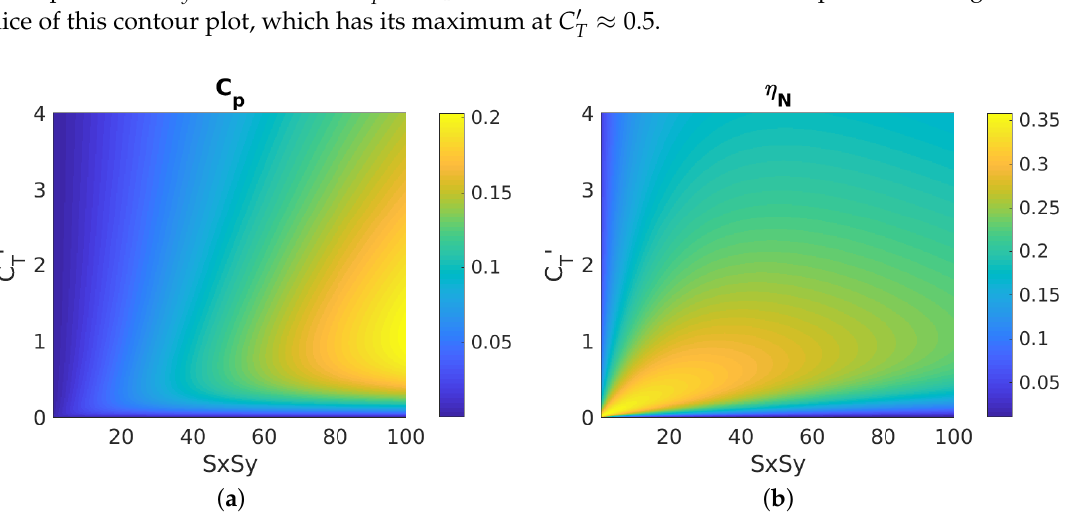
Figure 18. ( a ) Individual turbine power coefficient ( C P ) as a function of local thrust coefficient and turbine spacing, with other parameters held fixed, predicted using Nishino’s model. ( b ) Wind farm power density ( η N ) as a function of local thrust coefficient and turbine spacing, with other parameters held fixed, predicted using Nishino’s